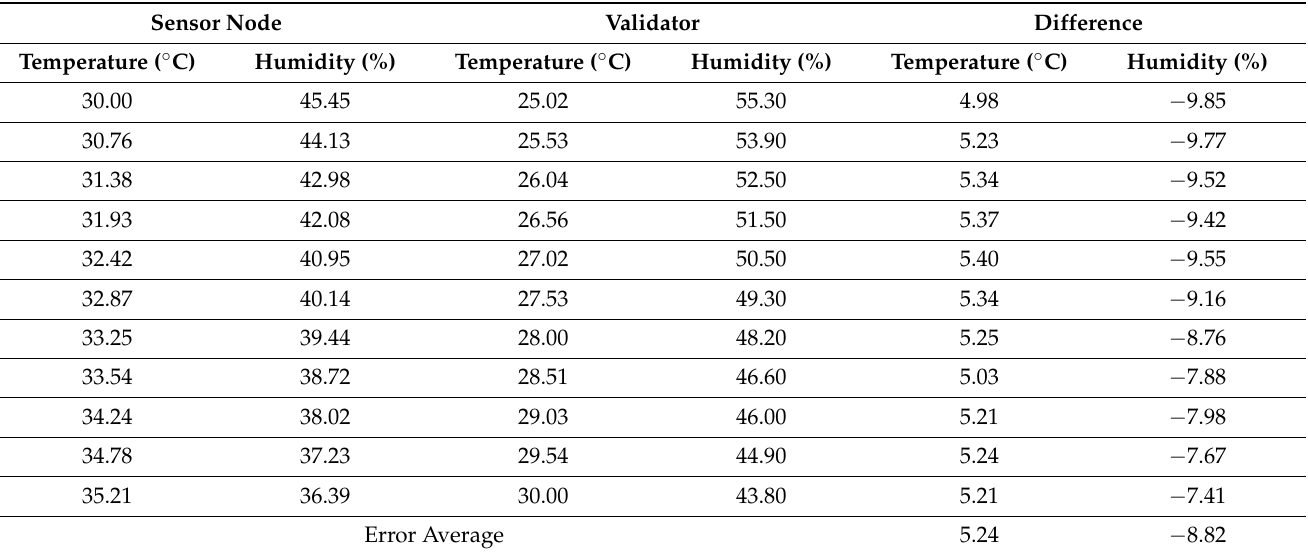
Table 10. Measurement results before